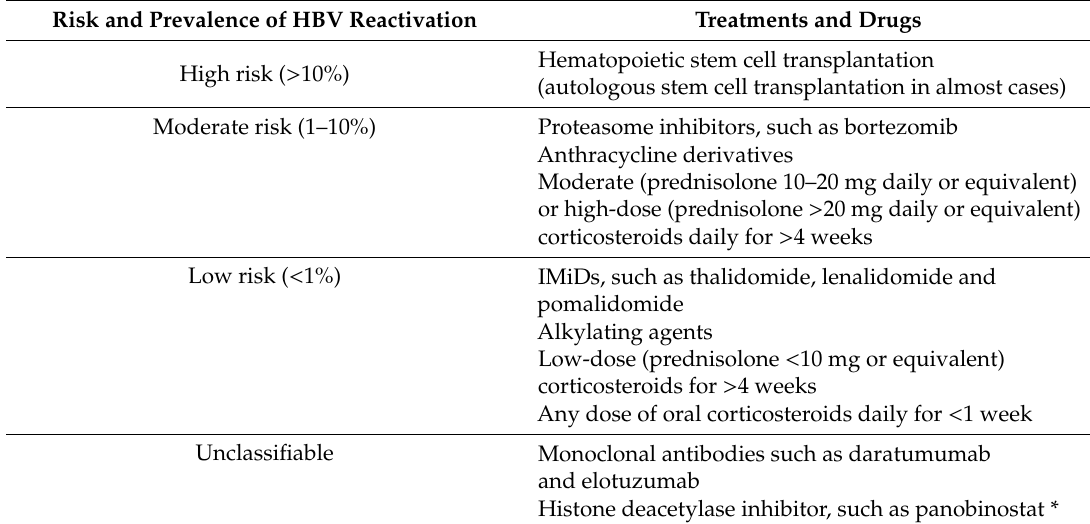
Table 2. Risk classifications of treatments and drugs resulting in multiple